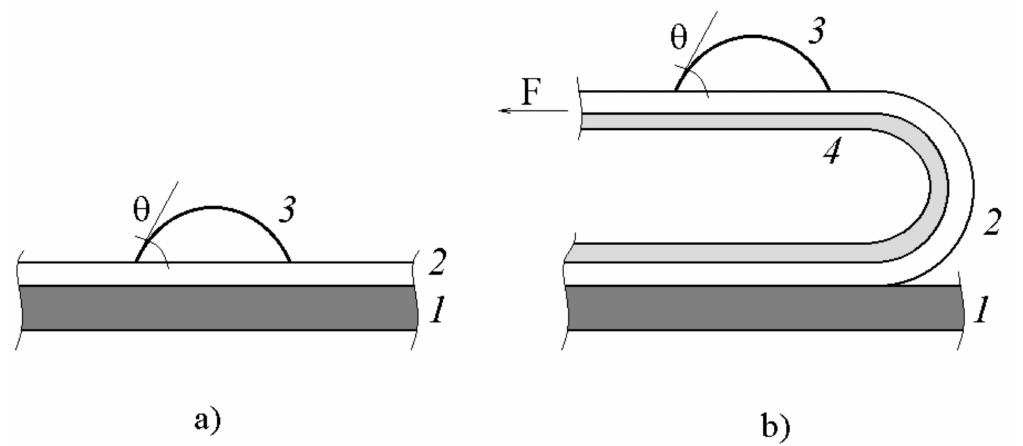
Figure 2. Adhesion joint testing. ( a ) Determination of contact angles of PAI adhesive films; ( b ) peeling of PAI adhesive reinforced by 3M tape. (1) Substrate, (2) PAI adhesive; (3) test liquid droplet; (4) 3M tape; F is peeling force applied at 180 ◦